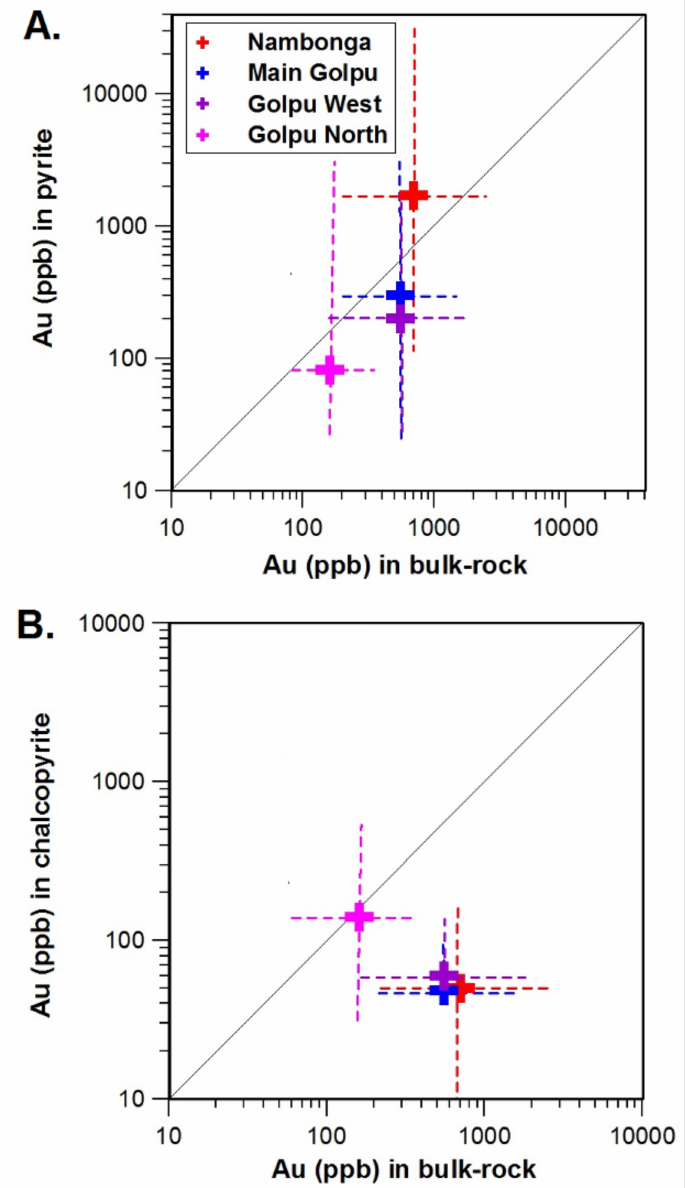
Figure 8. Geometric mean for the Au distribution of pyrite and chalcopyrite compared with the geometric mean Au values of the bulk-rock from the Golpu, Golpu West, Golpu North and Nam- bonga North porphyries. ( A ) Au in pyrite, and ( B ) Au in chalcopyrite. Dashed line defines 1 σ variation